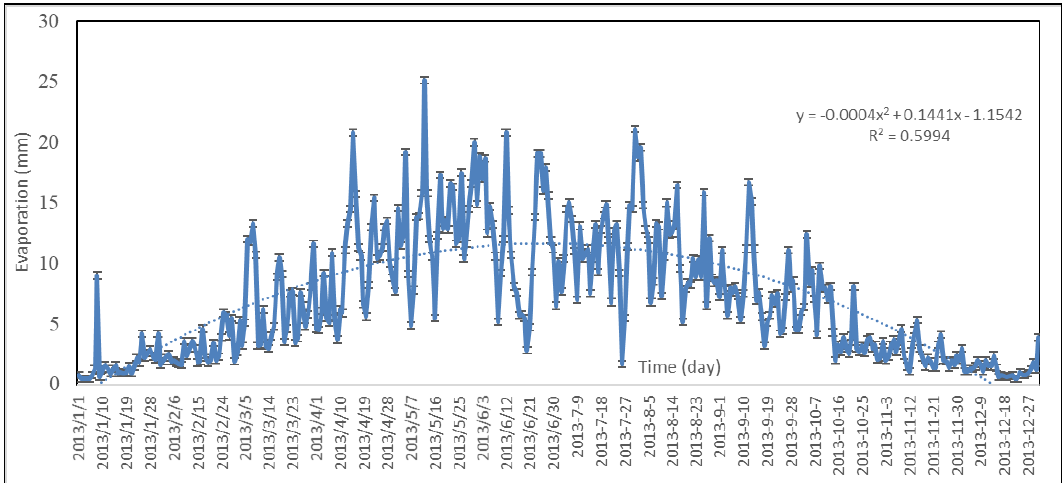
Figure 3. Daily evaporation in the year 2013.